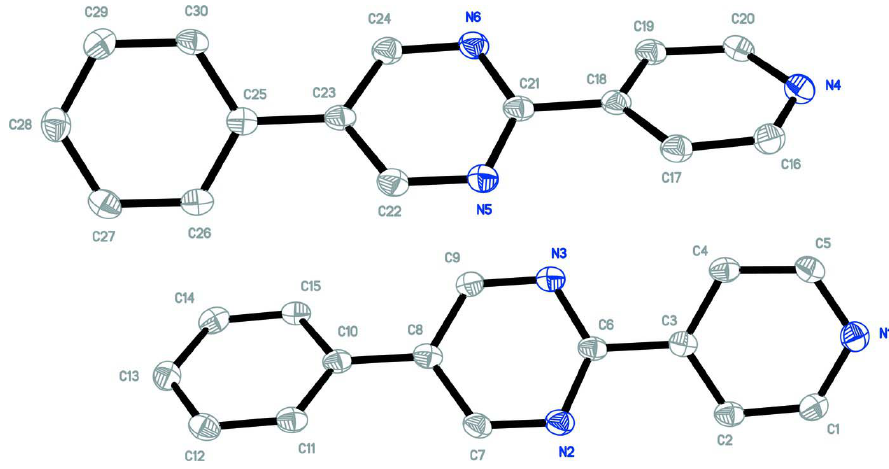
Figure 1 The asymmetric unit with thermal ellipsoids shown at 50% probability levels. H atoms have been